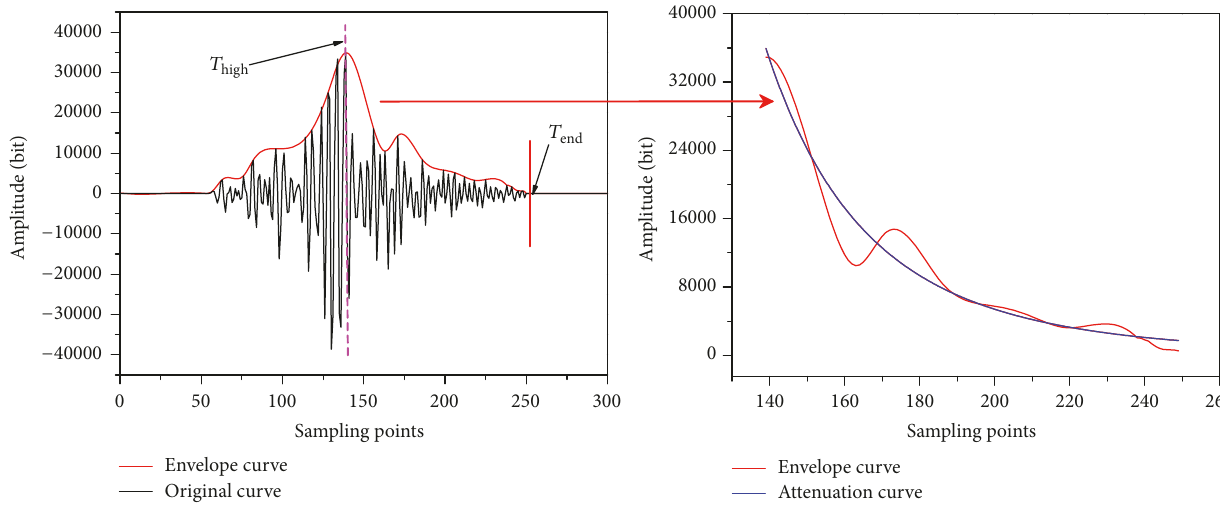
Figure 5: Following peak attenuation curve of typical coal mining MS